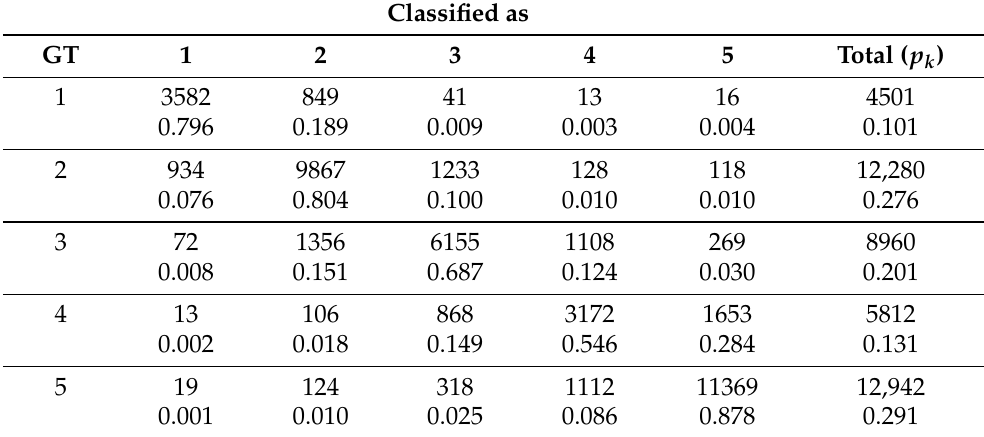
Table 1. Observed accuracy (absolute and θ kj ) of identifying field sizes. GT is the expert control points or ground truth, and ’Classified as’ refers to the user classifications. The numbers 1 to 5 are the field size classes ranging from very large to very